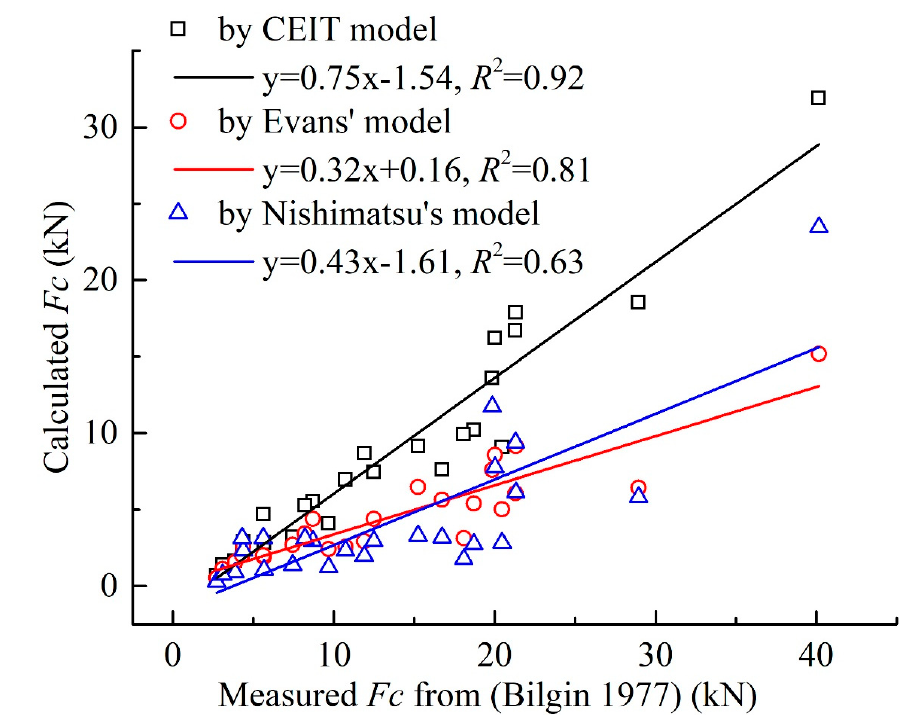
Figure 12. Comparison of the performance of different models in estimating the peak cutting forces in cutting limestone.